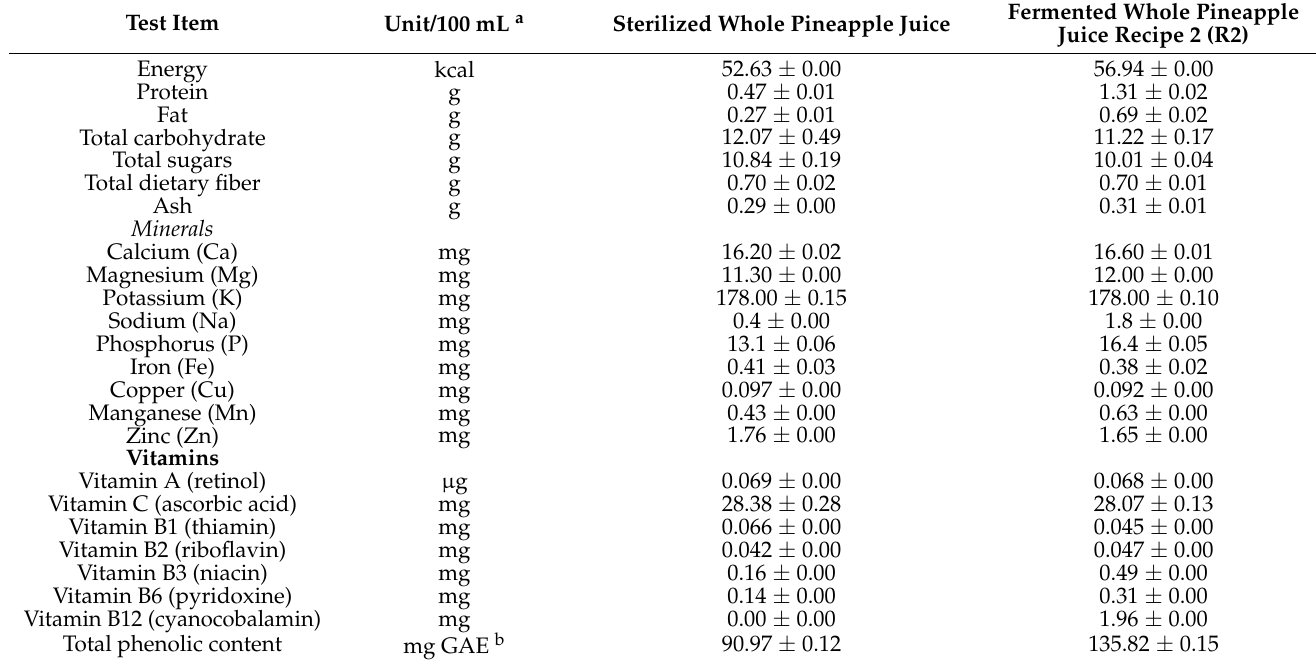
Table 2. Nutritional analysis of the sterilized whole pineapple juice and the fermented whole pineapple juice Recipe 2 (R2). Test